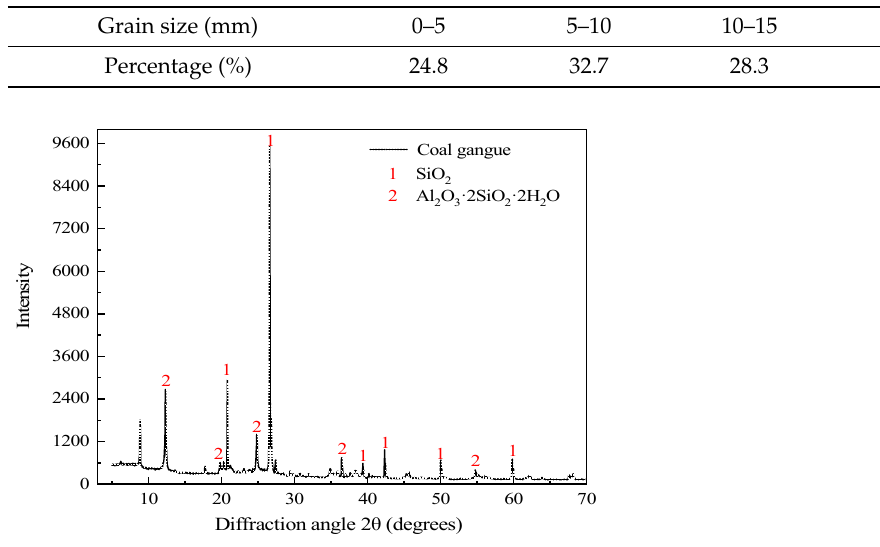
Figure 1. XRD diffraction qualitative analysis pattern of coal gangue.